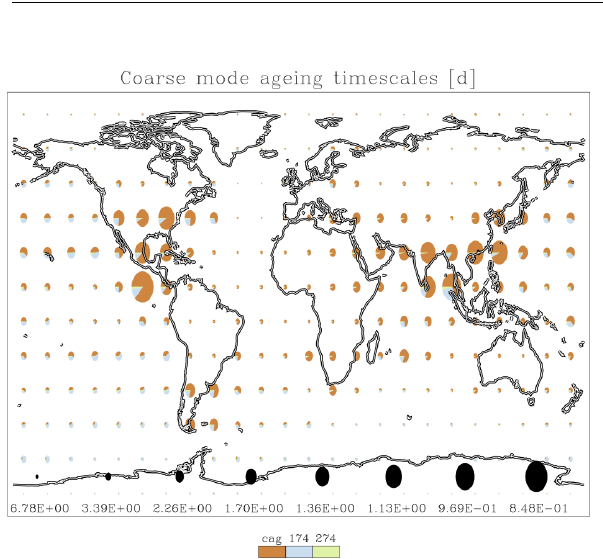
Figure 21. Aging timescales of the hydrophobic coarse mode. This (cid:16) ∂N (cid:17) timescale is defined as N/ , with N the number density and ∂t ∂N its time derivative due to aging processes only. The colors in- ∂t dicate processes (Table 2), the radius of the pie indicates the aging timescale (inverse linear